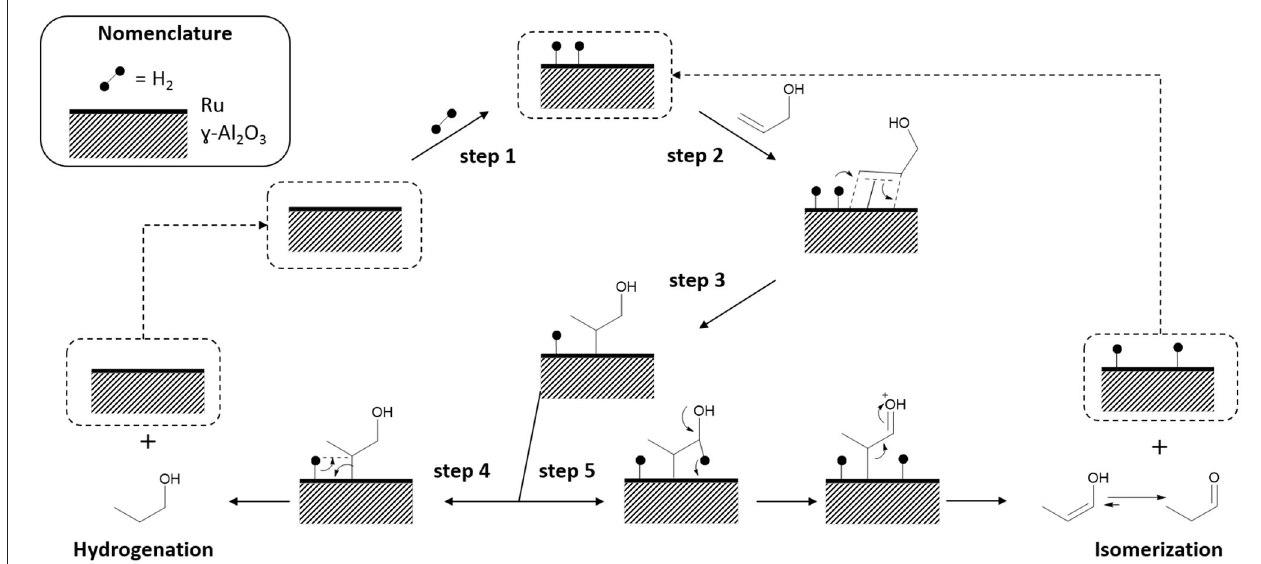
FIGURE 12 | Proposed mechanism for the isomerization of allyl alcohol by Ru 0 Ru n + /Al 2 O 3